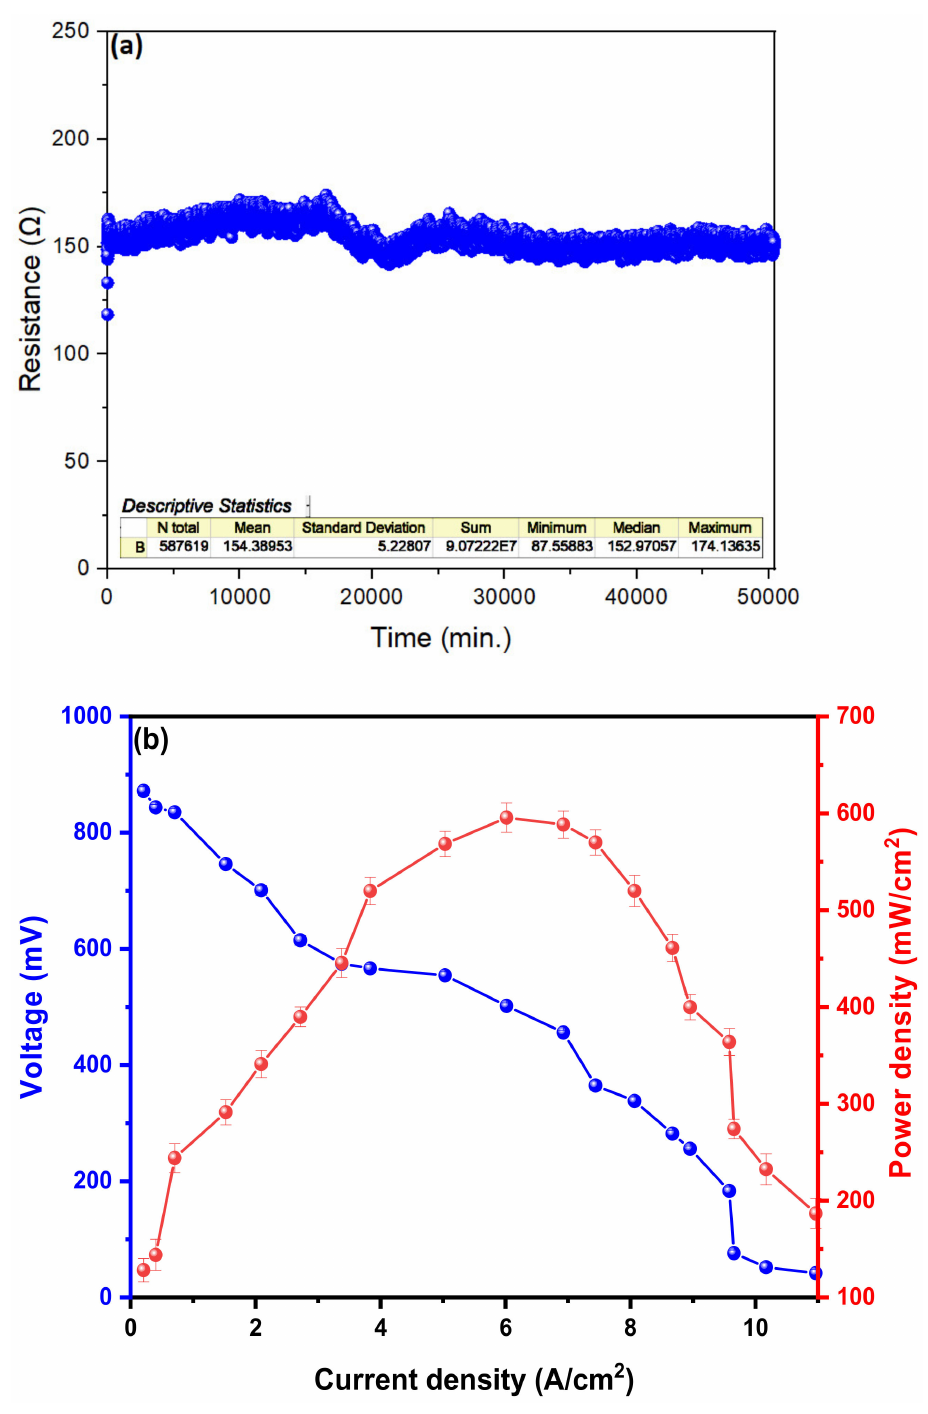
Figure 4. Characterization of ( a ) internal resistance and ( b ) power and voltage density about the current density of the